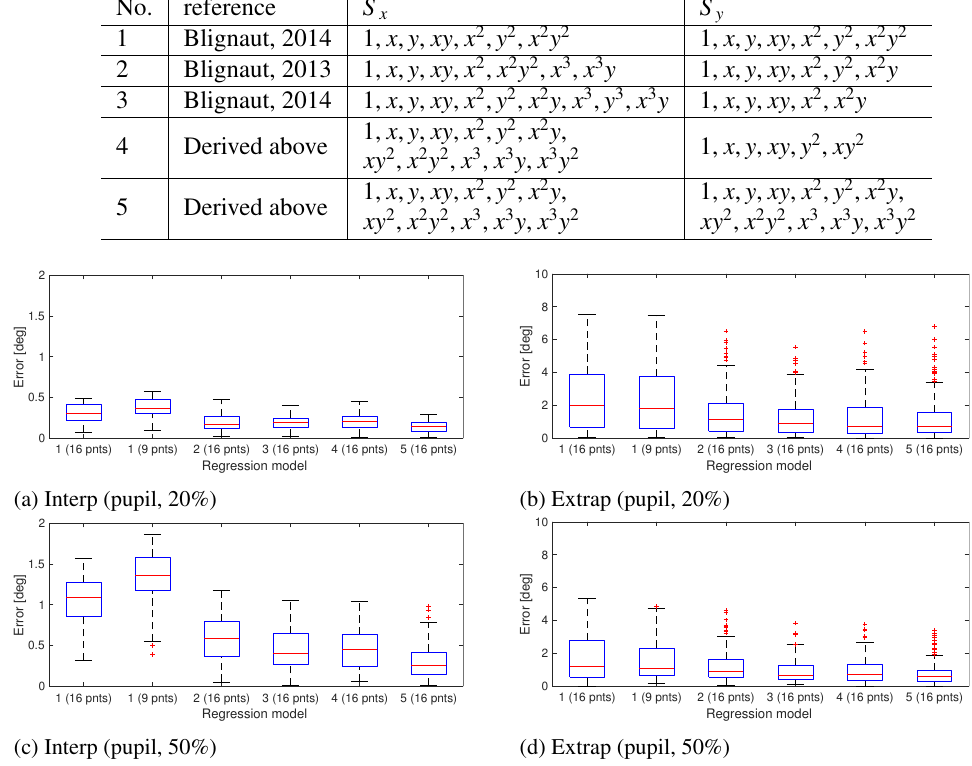
Figure 7 . Gaze estimation error obtained from di ff erent regression models for interpolation and extrapolation regions of the scene image. Gaze estimation was based on the Pupil center and no measurement noise was applied to the eye image. Errors are measured in